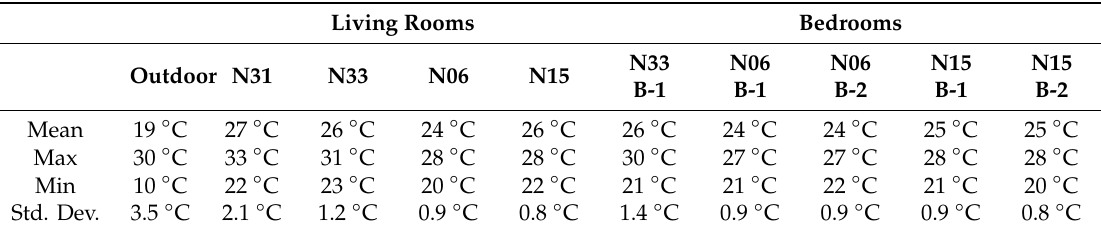
Table 7. Descriptive statistics for outdoor and indoor temperature measurement for all rooms, for all hours of the monitored